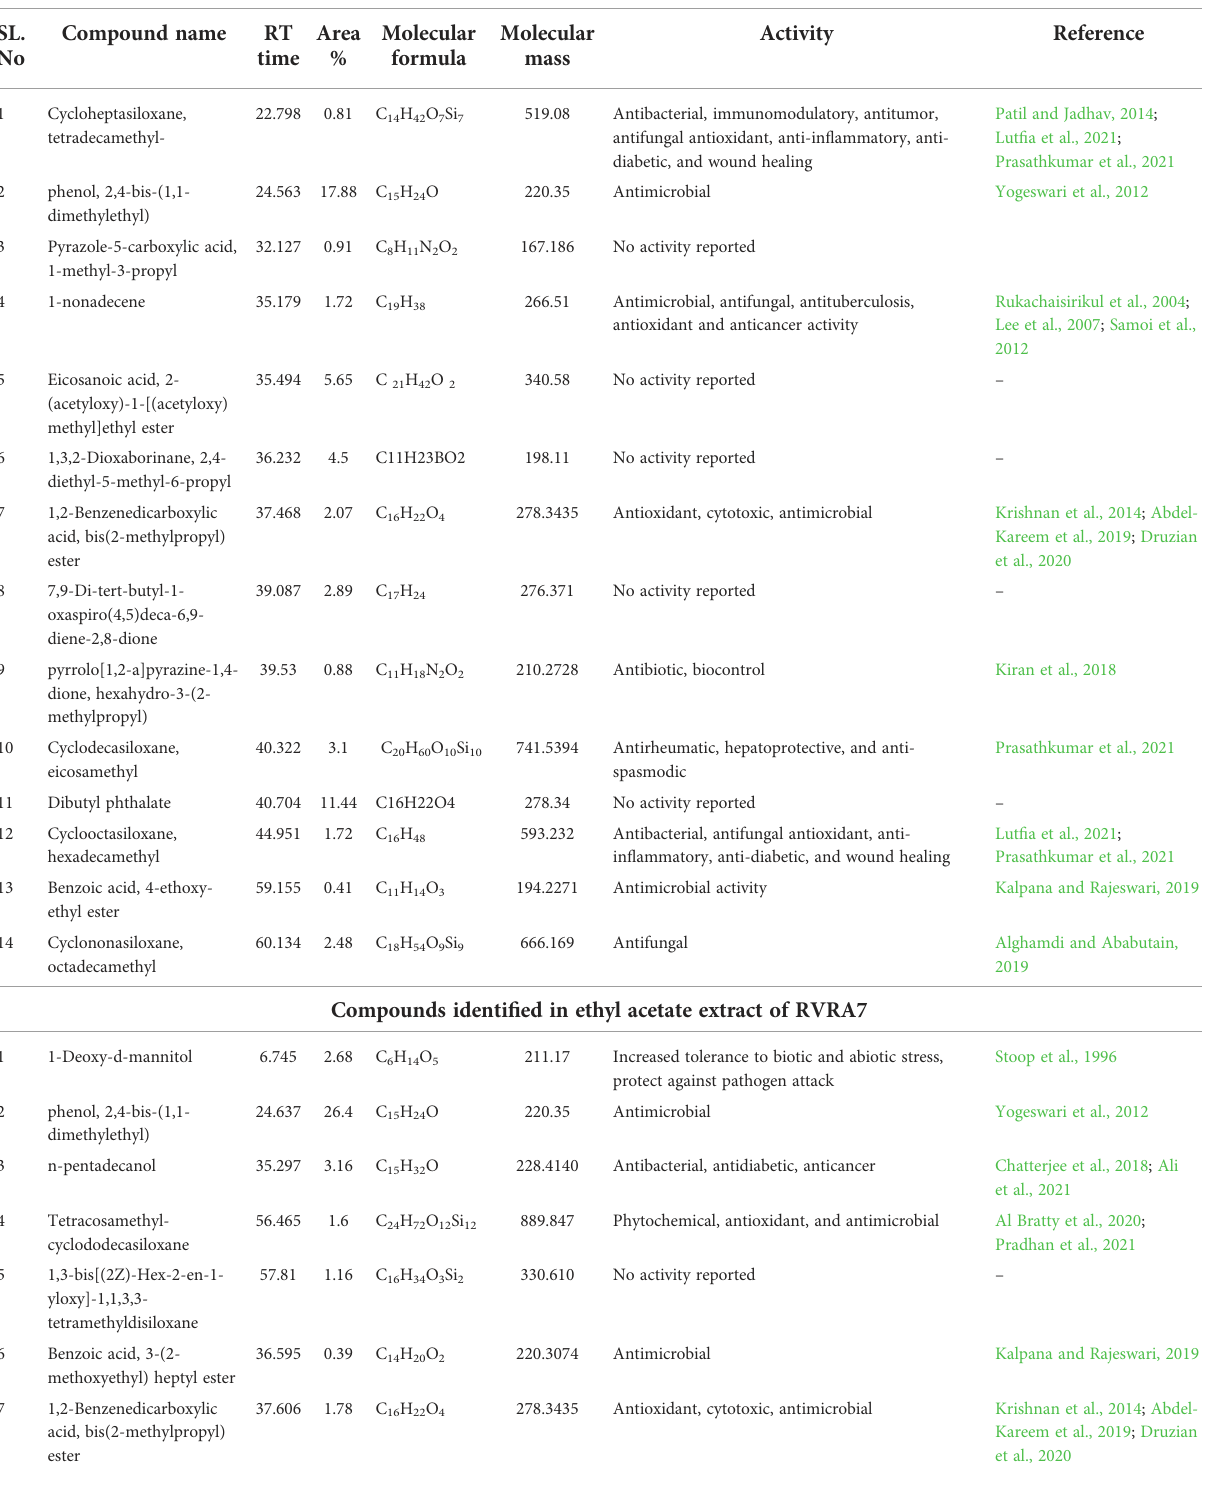
TABLE 5 Compounds identi fi ed from the ethyl acetate crude extract of Streptomyces sp. VCLA3 and Streptomyces sp. RVRA7 through GC-MS. Compounds identi fi ed in ethyl acetate extract of VCLA3